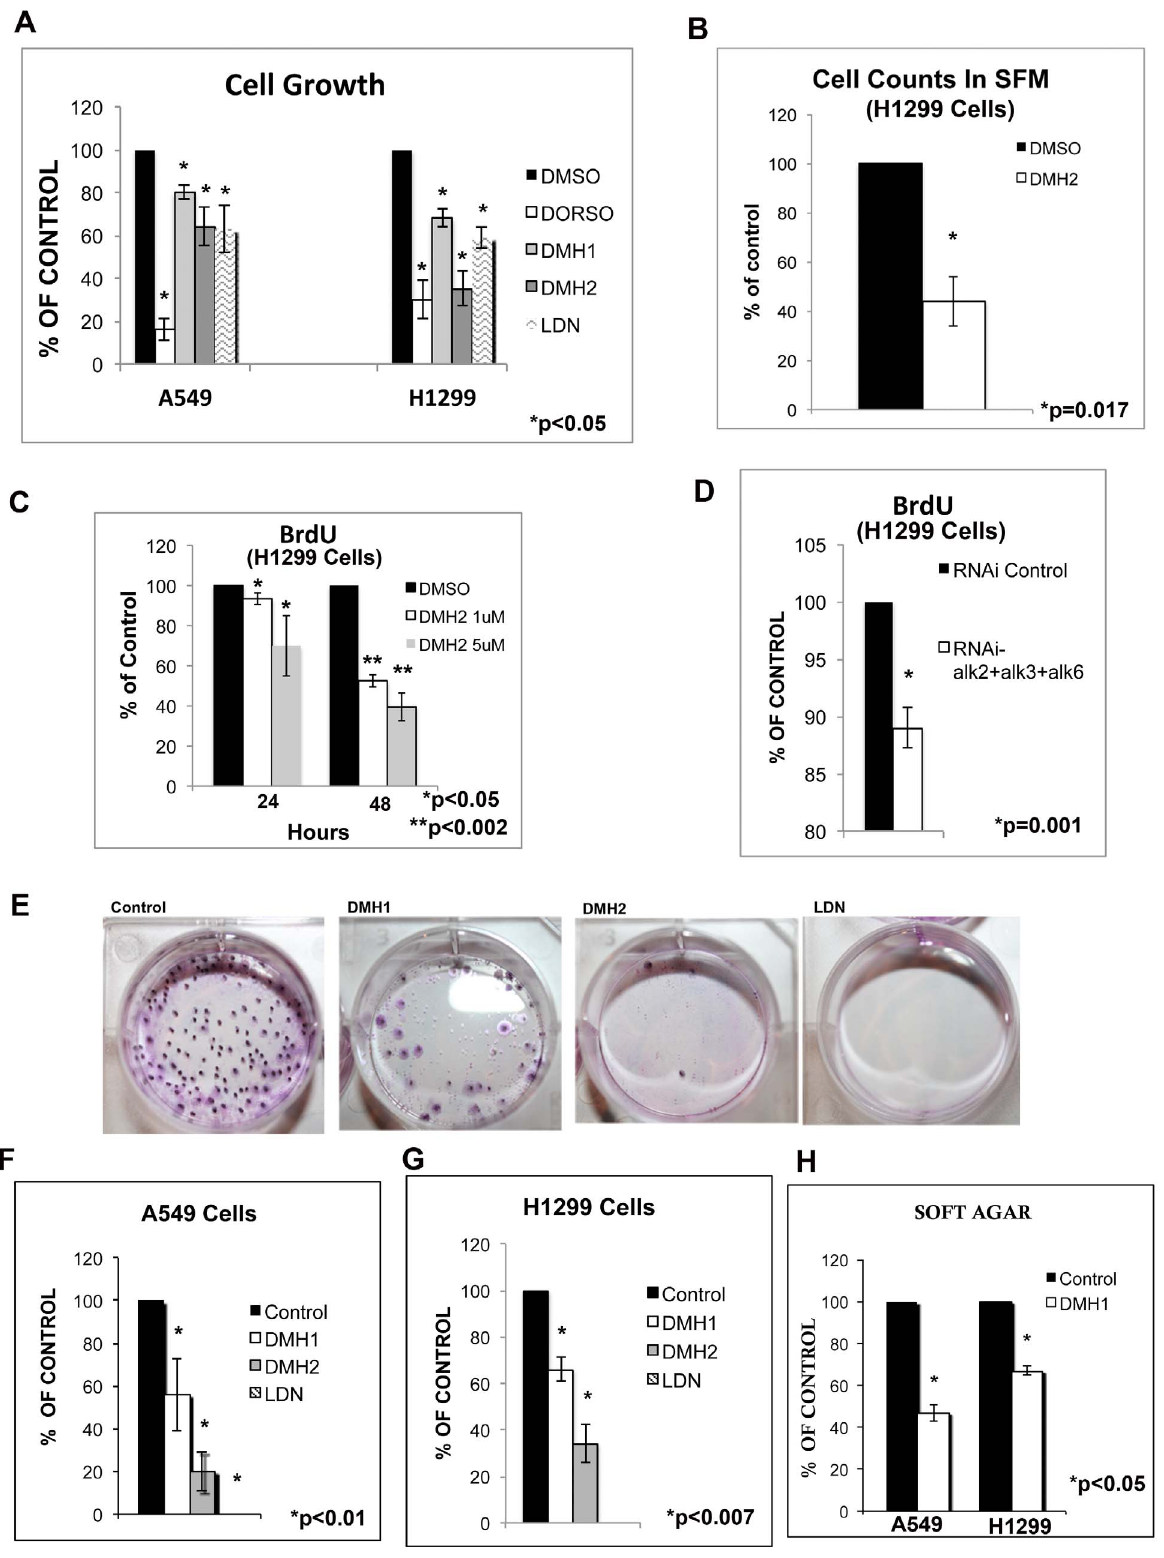
Figure 4. Antagonizing BMP type I receptors decreases cell growth, proliferation, and clonogenicity of lung cancer cell lines. ( A ) A549 and H1299 cells cultured in DMEM 5% FCS were treated with DMSO, 10 m M Dorsomorphin, 1 m M DMH1, 1 m M DMH2, or 1 m M LDN for 7 days and cell counts performed. ( B ) H1299 cells cultured in SFM were treated with 1 m M DMSO or 1 m M DMH2 for 7 days and cell counts performed. ( C ) BrdU incorporation of H1299 cells treated with DMSO or 1 m M or 5 m M DMH2 for 24 and 48 hours. ( D ) BrdU incorporation of H1299 cells transfected